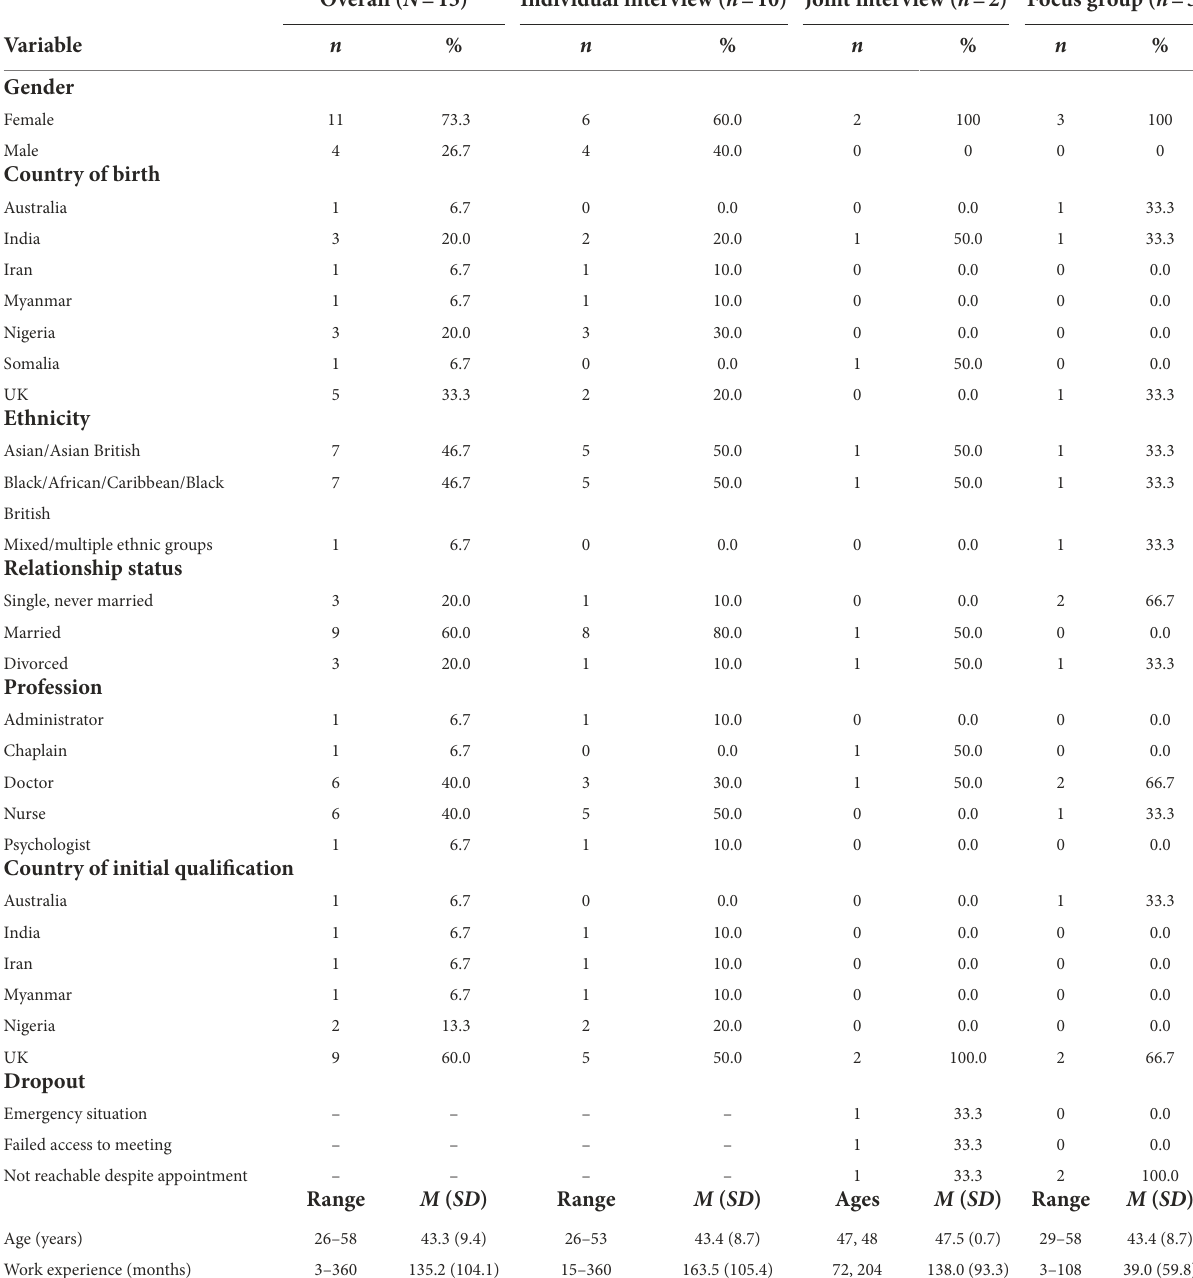
TABLE 2 Summary of participant